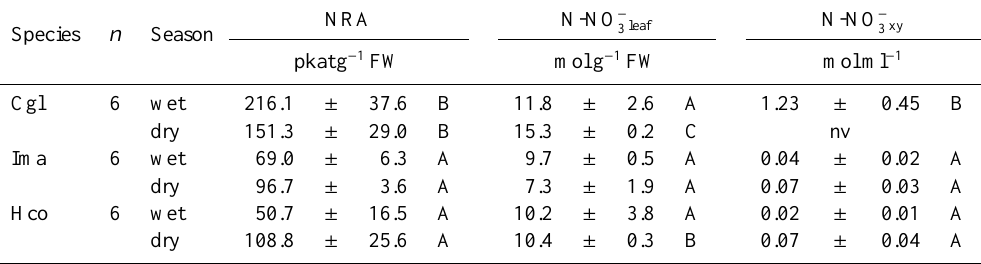
Table 3. One-Way ANOVA comparison tests with Duncan’s test a posteriori. Mean ± SD to nitrate reductase activity (NRA), Nitrate in leaves (N-NO − 3leaf ) and in xylem sap (N-NO − 3xy ) for Cgl ( Cecropia glaziovi ), Ima ( Inga marginata ) and Hco ( Hymenaea courbaril ). Means indicated by di ff erent letters are statistically significant at 5%. nv – not verified.